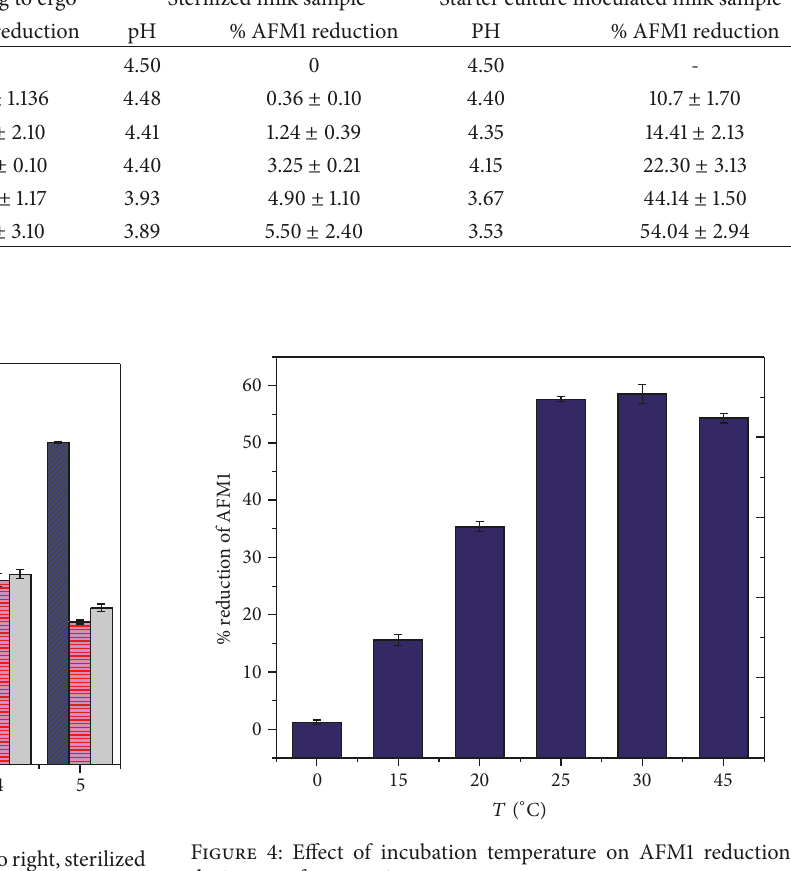
Figure 3: ELISA results of the fate of AFM1 in, left to right, sterilized (Sc), raw (Sr), and sterilized and starter culture inoculated (Sci) milk samples during incubation under traditional milk fermentation to Ethiopian naturally sour dairy product “ ergo .”